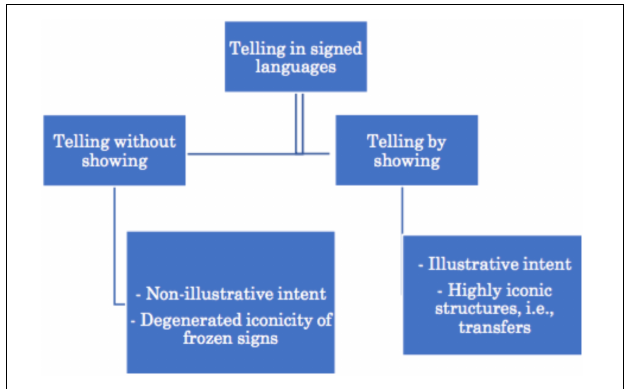
FIGURE 5 | Visualization of the relation between the different modes of communication and different sign types based on Sallandre